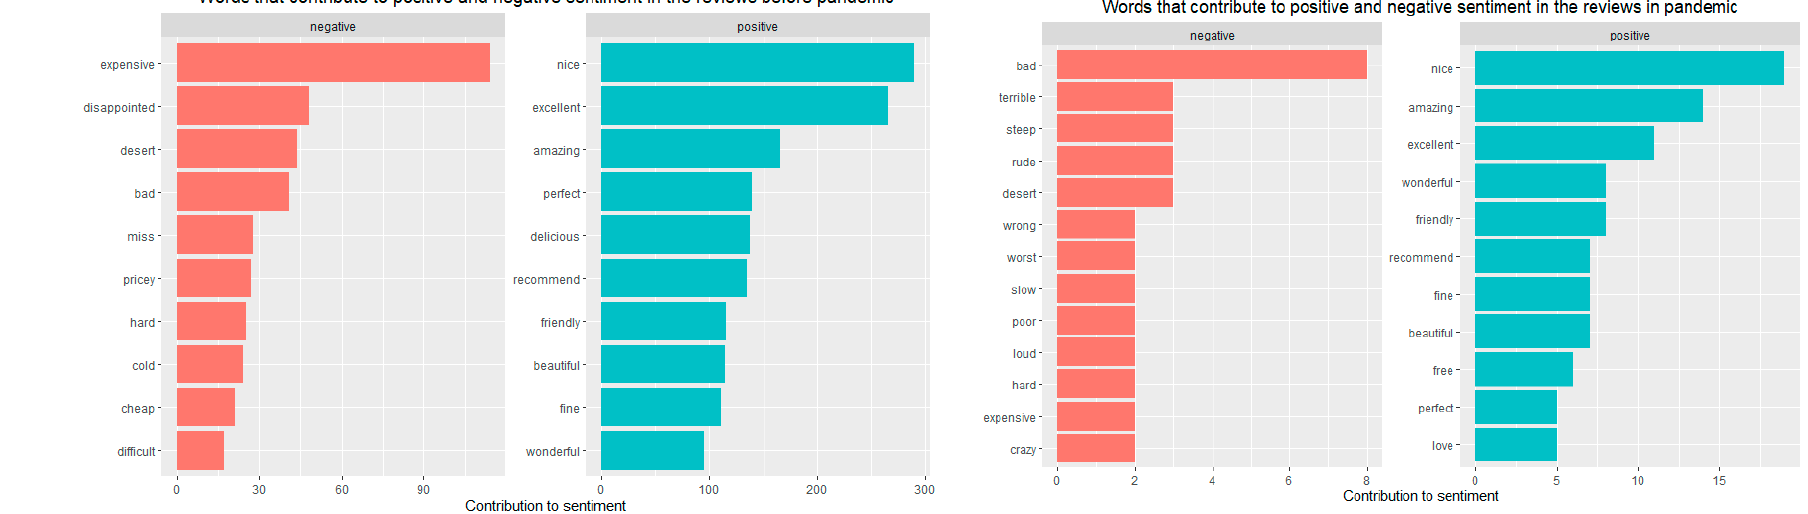
Figure 5. Words that contribute to positive and negative sentiment in the reviews before and during the pandemic.